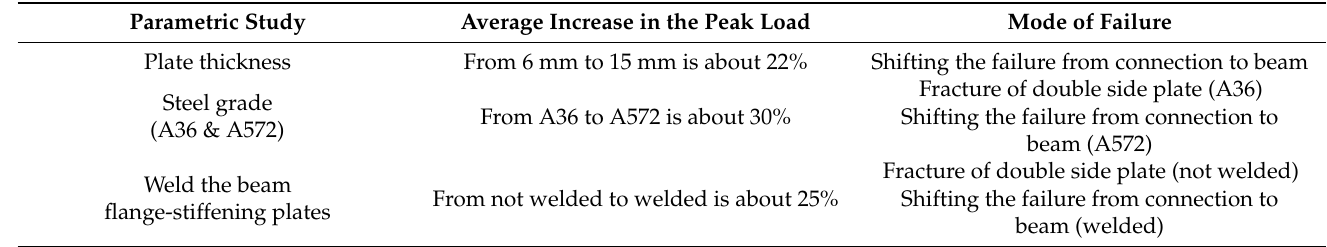
Figure 18. FEM force-displacement response for welded A36 & A572 specimens.